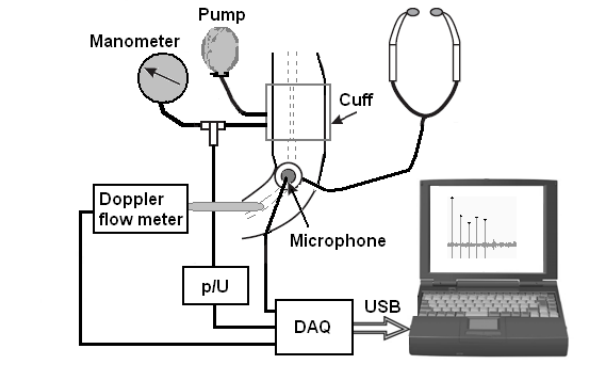
Fig. 2. The measurement system for data acquisition.